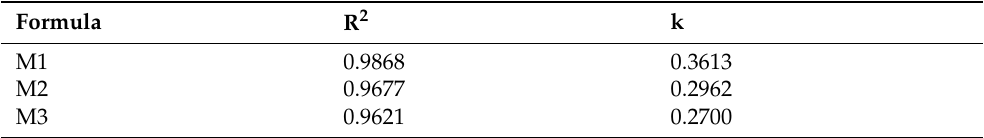
Table 4. The Korsmeyer-Peppas model’s rate constants (k) and R 2 of the swelling